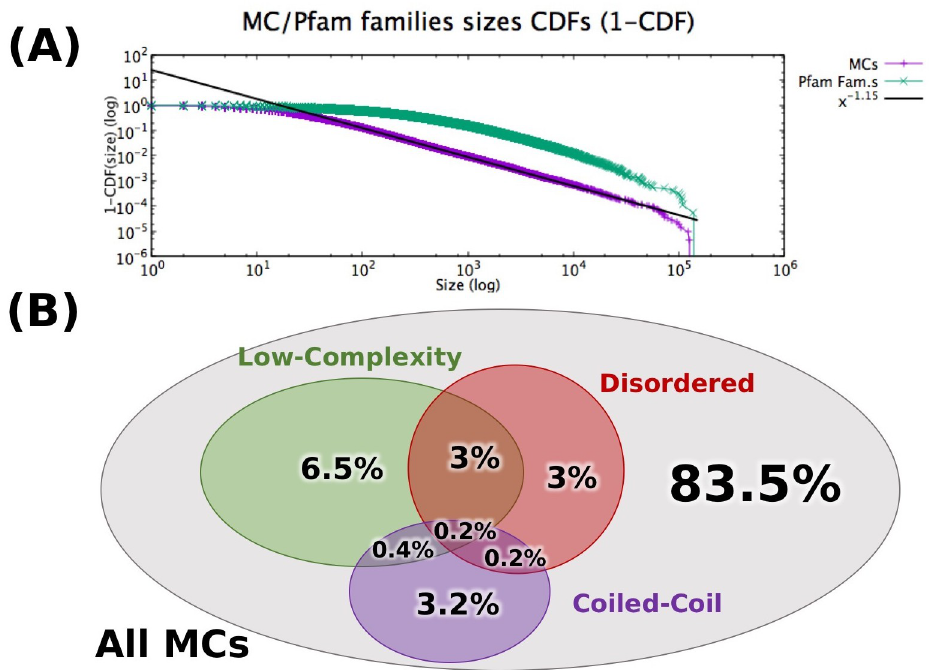
Fig 3. General properties of Metaclusters. A Cumulative Distribution Function (1-CDF) of MC (purple) and Pfam family (green) sizes. All 210,802 MCs have been considered, with the size of a MC equal the number of its seed sequences. Pfam families (v. 33) are all those in Uniref50 \ UniprotKB (18,189 total) and family size is the ‘full’ size, that is, not only considering Pfam seed sequences. Black line: best fit of MC’s CDF with a power-law (CDF exponent γ = − 1.15, corresponding to an exponent of − 2.15 of the Probability Distribution Function). In S3 Fig, we additionally plot the size of MCs/Pfam families as a function of their size rank. B : Venn diagram showing the percentage of Low Complexity MCs (green), Disordered MCs (red) and Coiled-Coil MCs (purple), respectively (see Methods for definitions). Note that, in this case, only MCs containing at least 50 seed sequences and with average length � 50 are considered (46,828